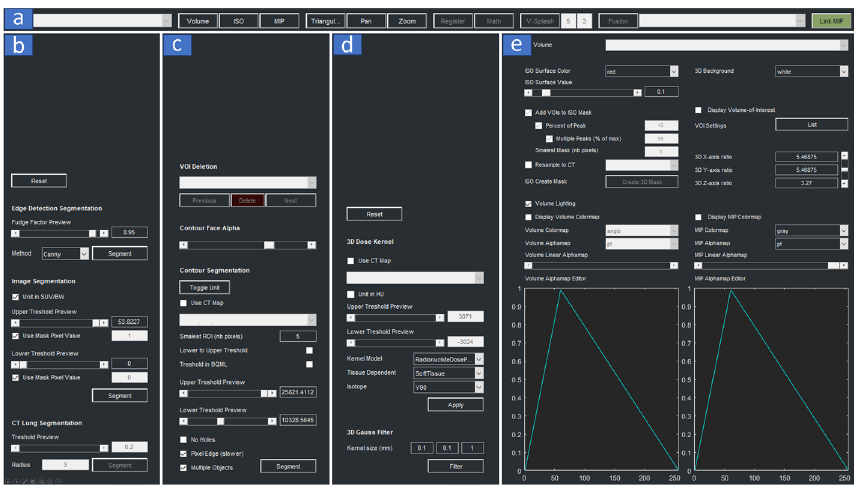
CERR, Computational Environment for Radiological Research; VOI, volume of interest